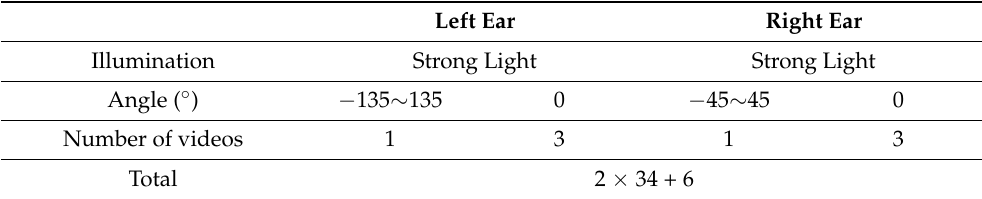
Table 9. Human ear database information of